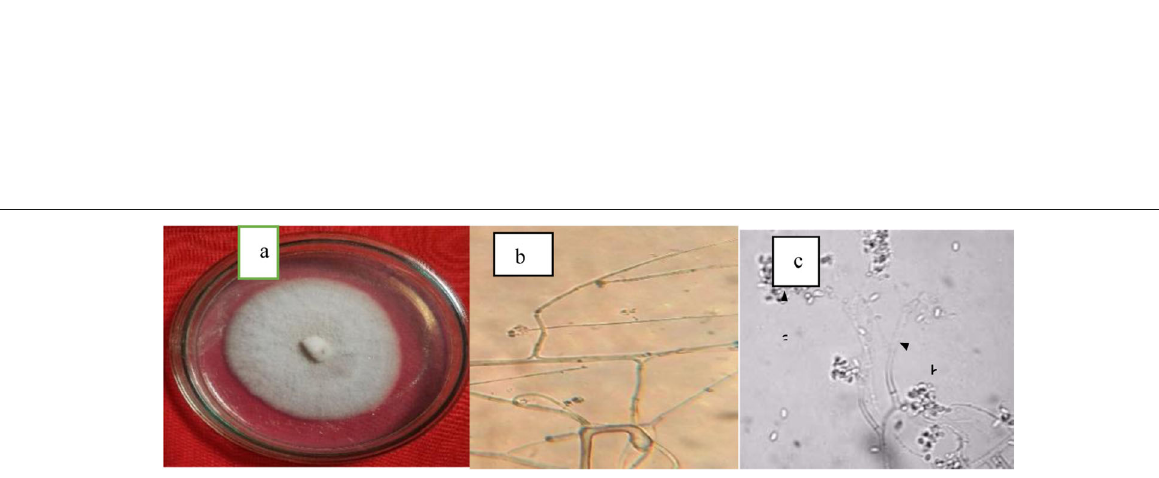
Fig. 2 a Colony of 8 days old Cipete (J34) isolate. b Beauveria sp. conidia (Minarni et al. 2020). c Beauveria bassiana conidia (Nuraida and Hasyim 2009)